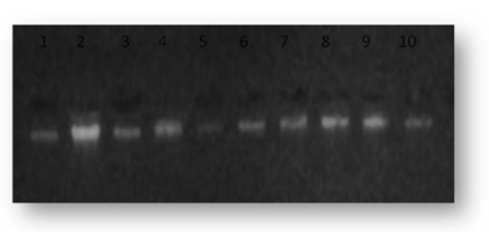
Fig. 2. The electrophoresis pattern of PCR product for MIR-196a2 gene ,this amplification product one band 174 bp for both patients and control ,1% agarose ,75V,20Am for 1h.Lane DNA marker, lane 1-10 PCR product of patient, lane 11-17 PCR products of